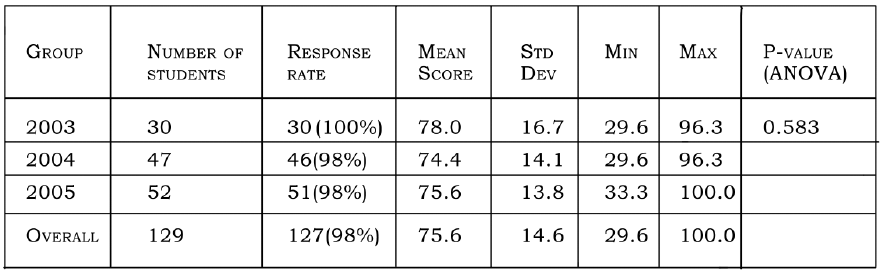
Table 1: Awareness percentage scores of students in